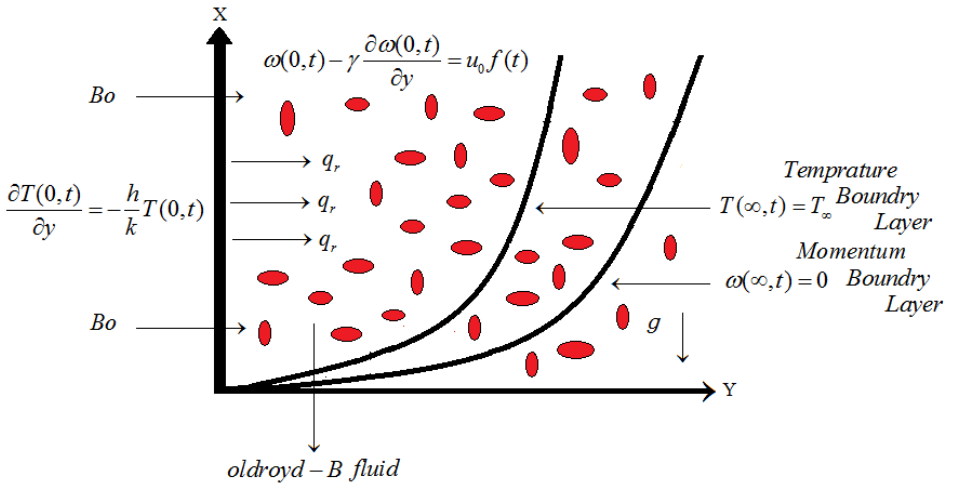
Figure 1. Geometrical formation of the flow